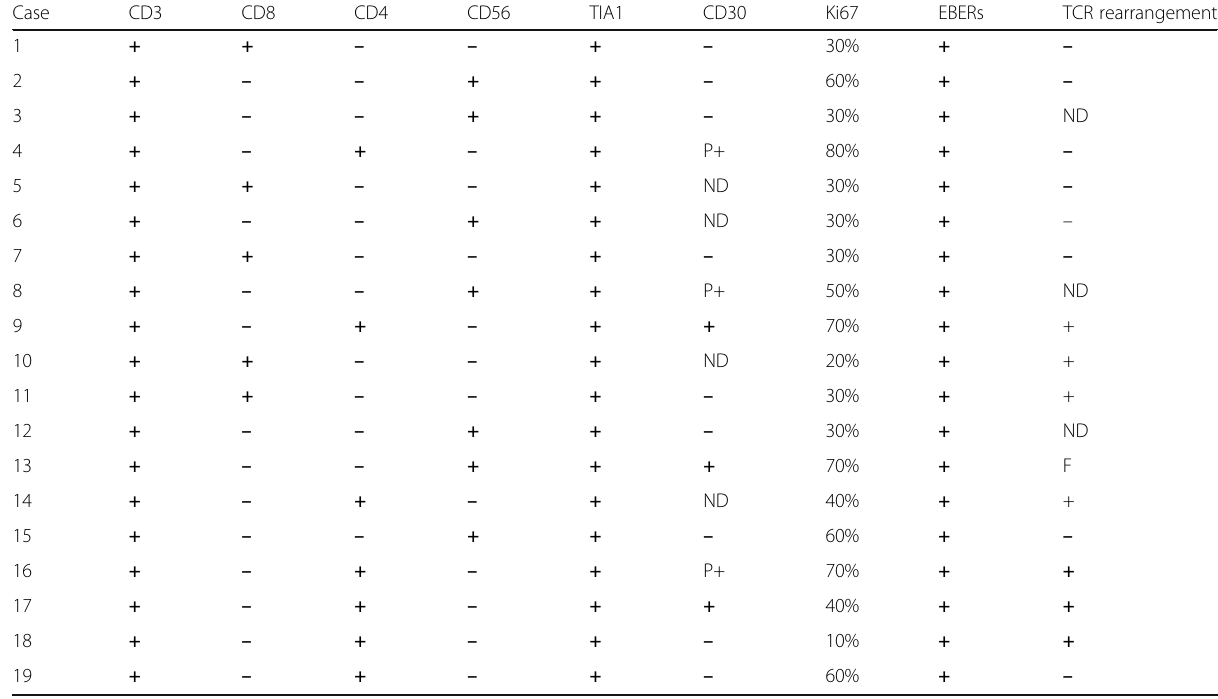
Table 3 Immunophenotype and molecular analysis of biopsies from 19 patients with HV-LPD Case